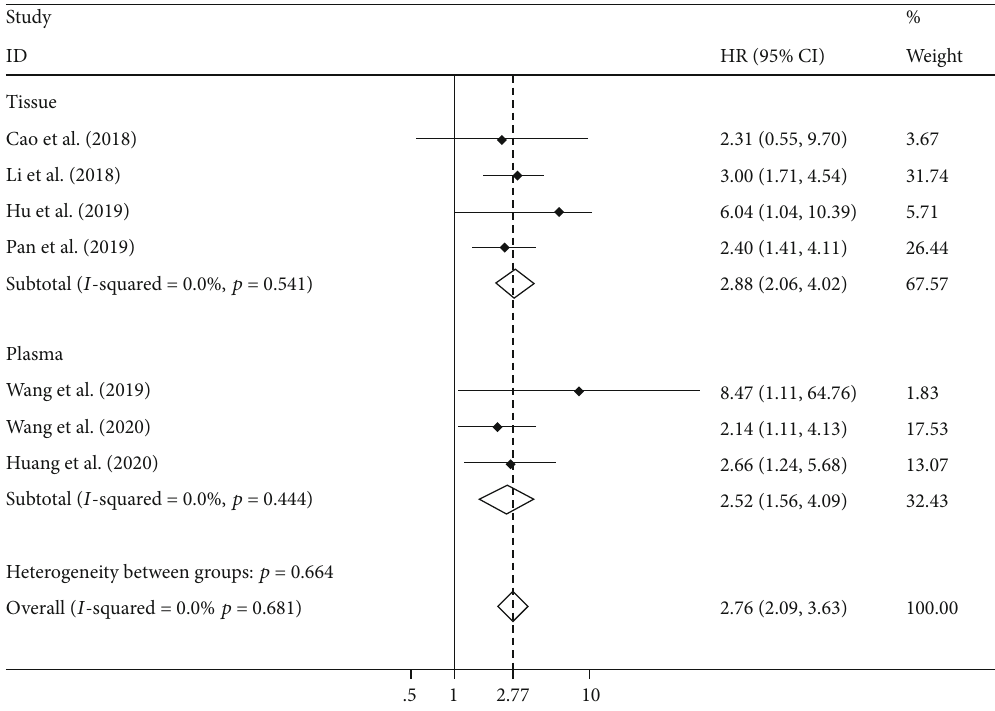
Figure 7: Subgroup analysis for verifying the relationship between tumor-promoter circRNA expression and overall survival prognosis. circRNAs, circular RNAs. Funnel plot with pseudo 95% confidence limits 0